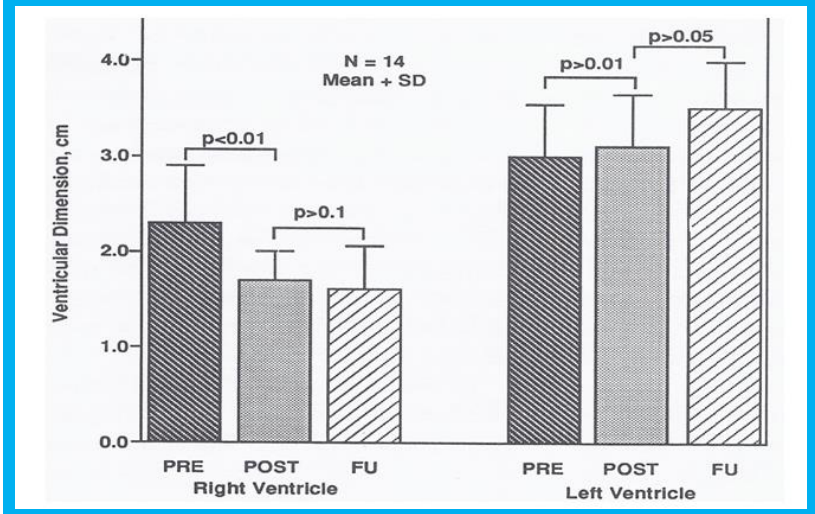
Figure 8. Bar graph illustrating the effect of transcatheter closure of atrial septal defect (ASD) with buttoned device on the left and right ventricular end-diastolic dimensions: Left panel shows that the dimension of the right ventricle fell ( p < 0.01) immediately following ASD closure. There was an additional but statistically insignificant ( p > 0.1) decrease in right ventricular dimension at follow-up (FU). The right panel demonstrates that there is no statistically significant change ( p > 05) either immediately after ASD closure or at FU. POST (on the day following ASD closure), on the day following ASD closure; PRE (prior to ASD closure), prior to ASD closure. Reproduced from Rao P.S., et al. [9].